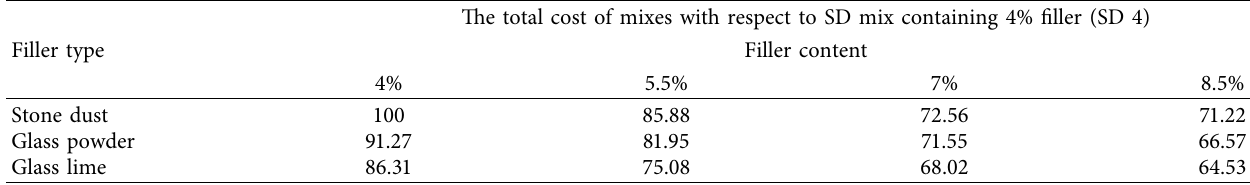
Table 8: Comparison of the final cost of different mixes.